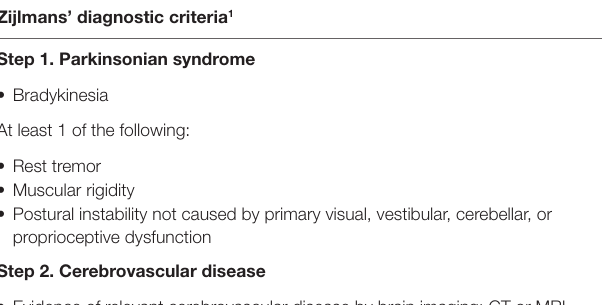
taBle 1 | Zijlmans’ vascular parkinsonism criteria.